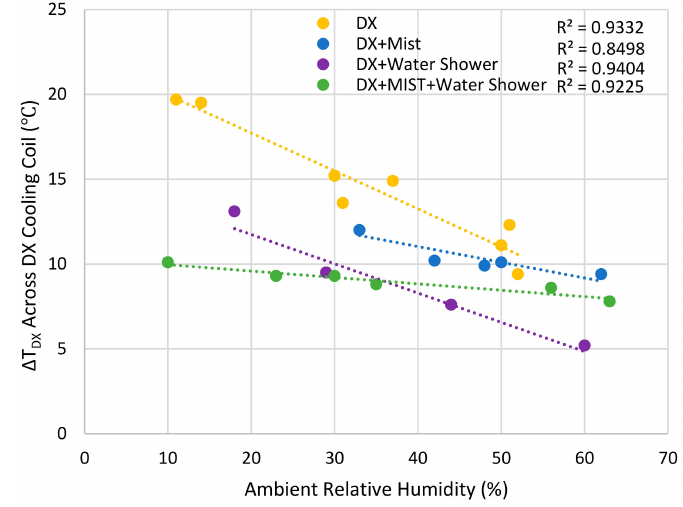
Figure 7. Variation of ∆ T DX with ambient relative humidity for ambient temperatures less than 40 ◦